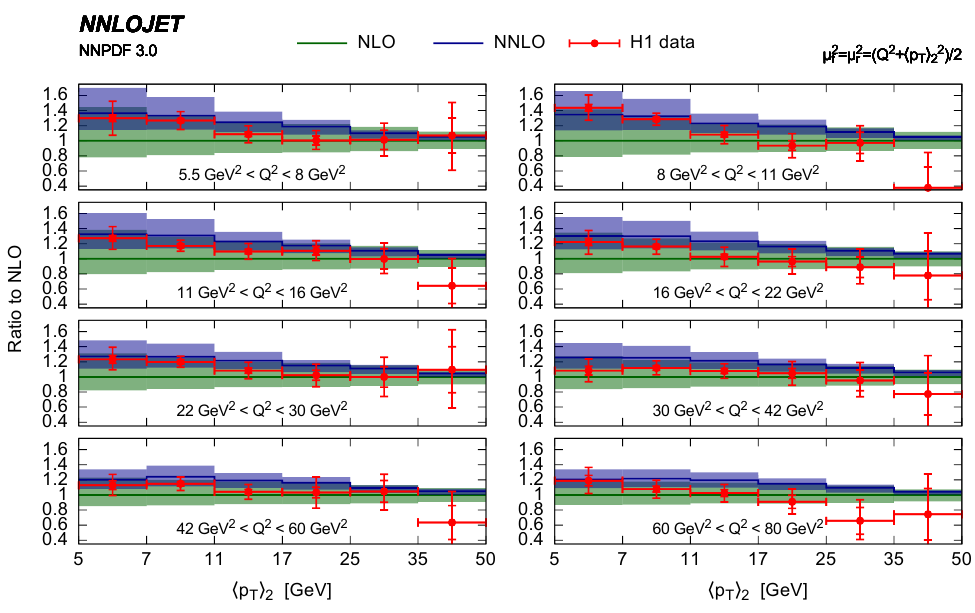
Figure 13 . Inclusive di-jet production cross section as a function of h p B to H1 low- Q 2